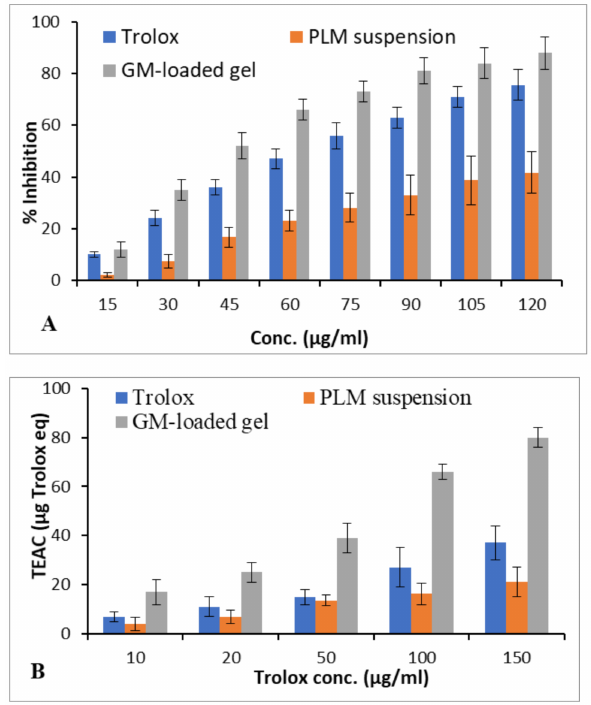
Figure 8. The antioxidant activities govern by DPPH assay of PLM suspension and GM-loaded gel. Percentage inhibitory effect of antioxidant ( A ). Trolex equivalent antioxidant activity (TEAC) of GM-loaded gel compared with trolox and PLM suspension ( B ). Values shown as means ± SD ( n = 3) analysed by one way ANOVA followed by Bartlett’s test for statistical significance ( p <